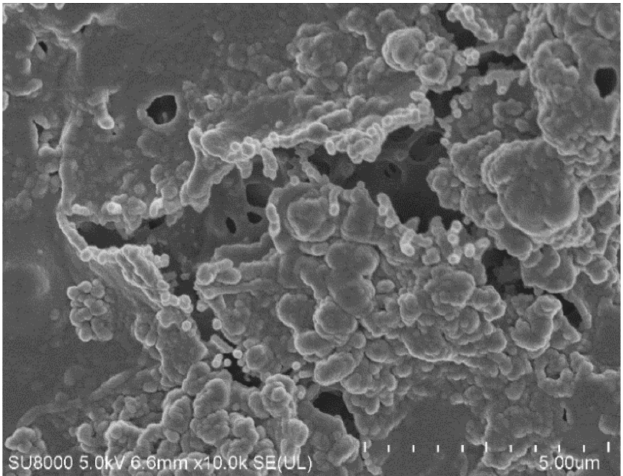
Figure 14. SEM images of membrane surface covered by deposit formed during desalination of Baltic Seawater contaminated with oil. Module